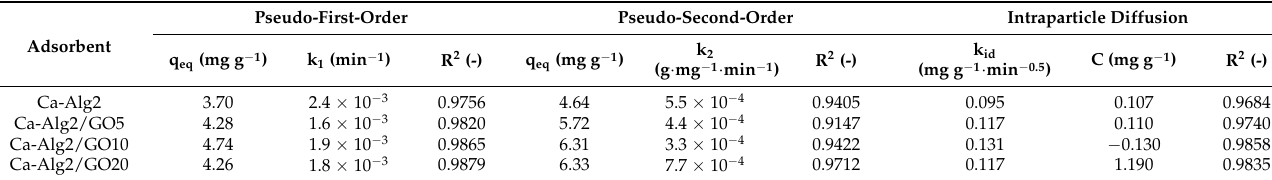
Table 6. Kinetic parameters for DFC adsorption onto Ca-Alg2, Ca-Alg2/GO5, Ca-Alg2/GO10 and Ca-Alg2/GO20 dried beads. Adsorbent